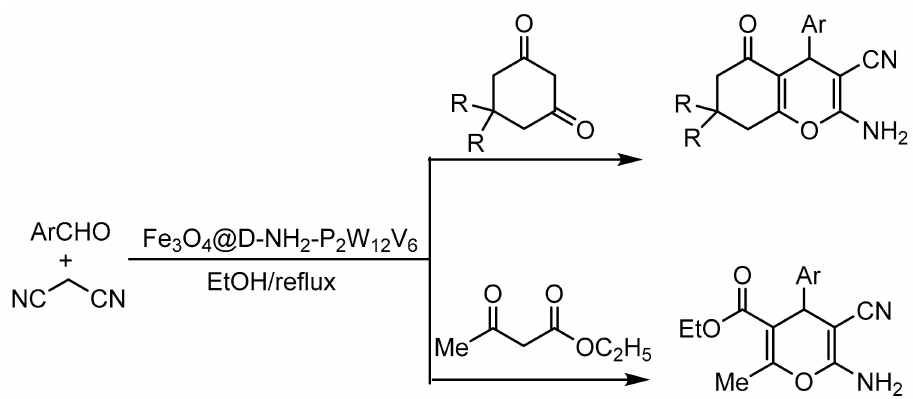
Scheme 29. Synthesis of highly substituted pyran